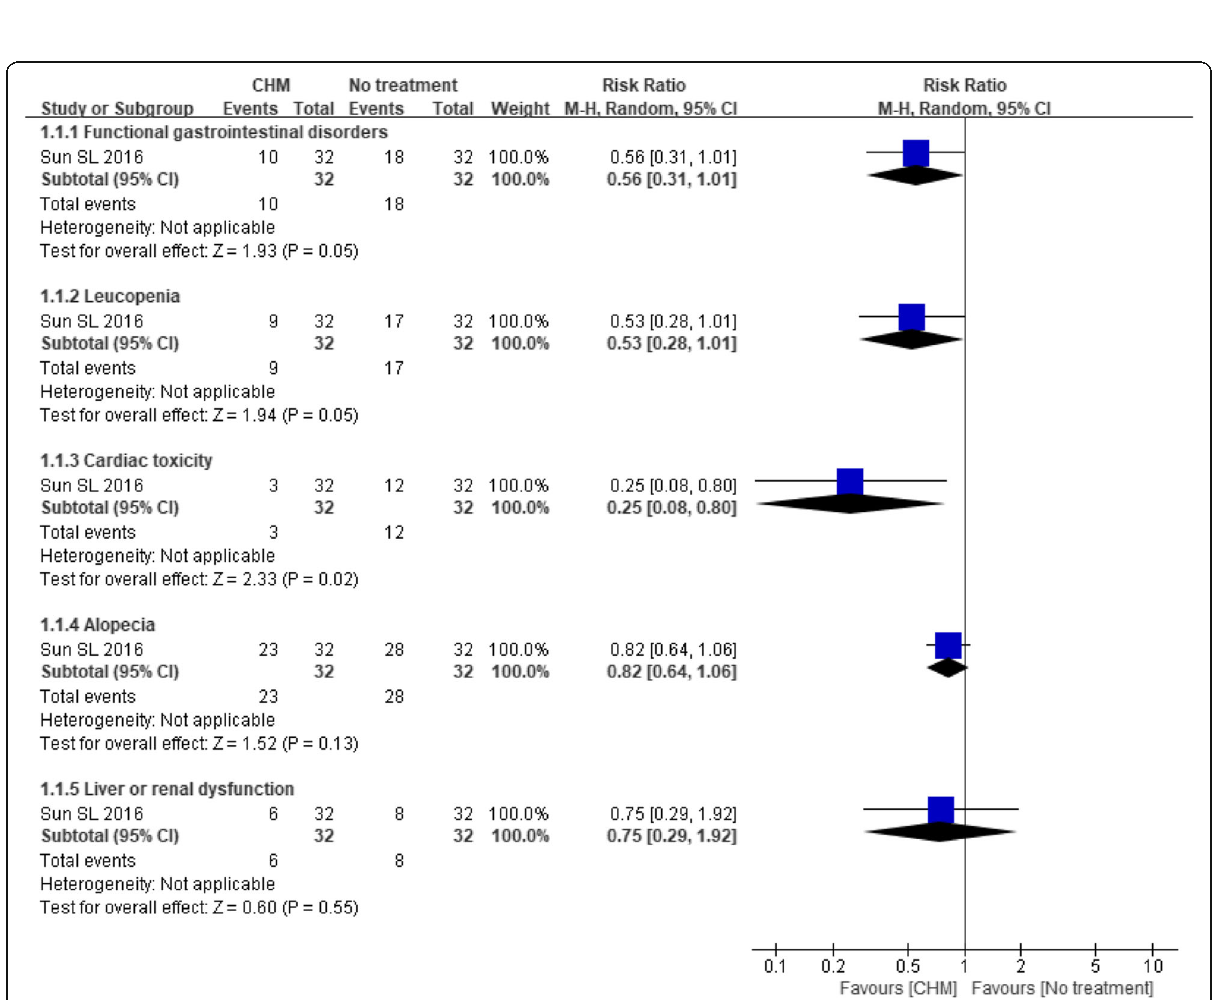
Fig. 14 Forest plot of adverse events for CHM versus no